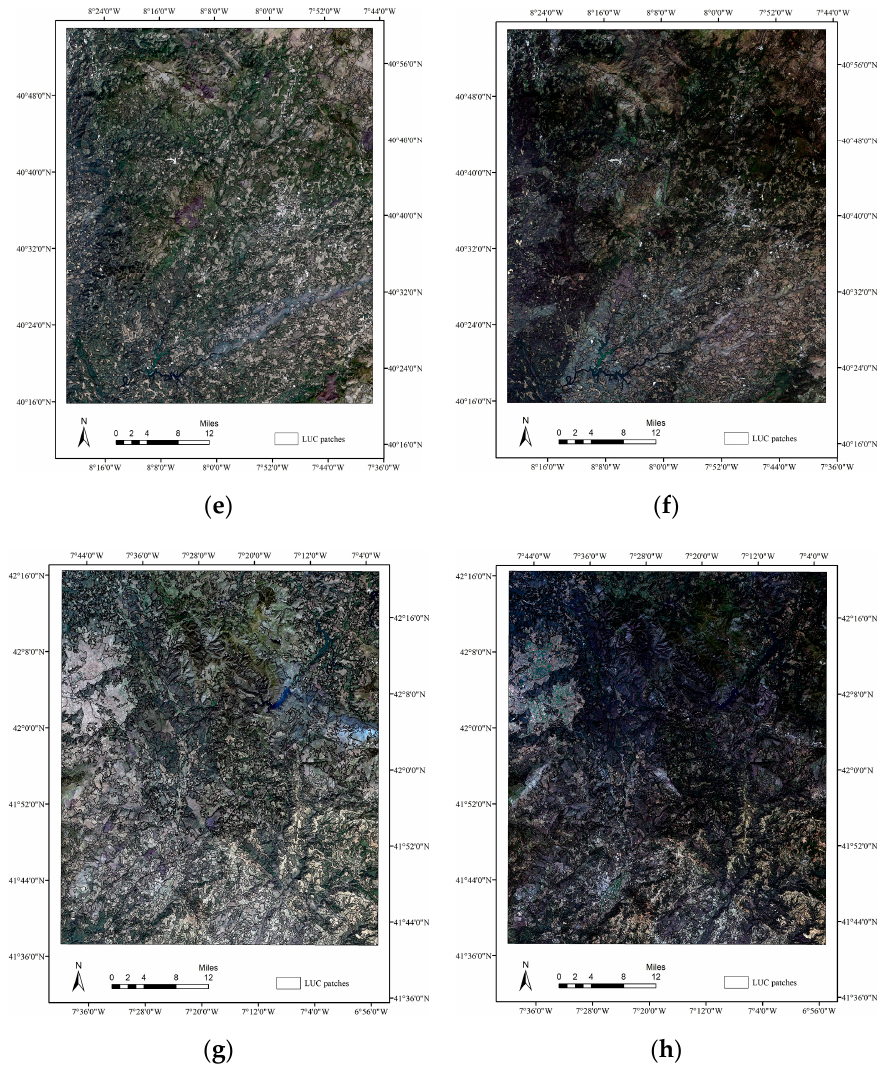
Figure 2. Datasets used in the study. Images showing land use/cover (LUC) patches in Dataset 1 on ( a ) 1 October 2016 and ( b ) 26 June 2018; Dataset 2 on ( c ) 1 October 2016 and ( d ) 26 June 2018; Dataset 3 on ( e ) 30 August 2000 and ( f ) 9 August 2018; and Dataset 4 on ( g ) 30 August 2000 and ( h ) 9 August 2018.